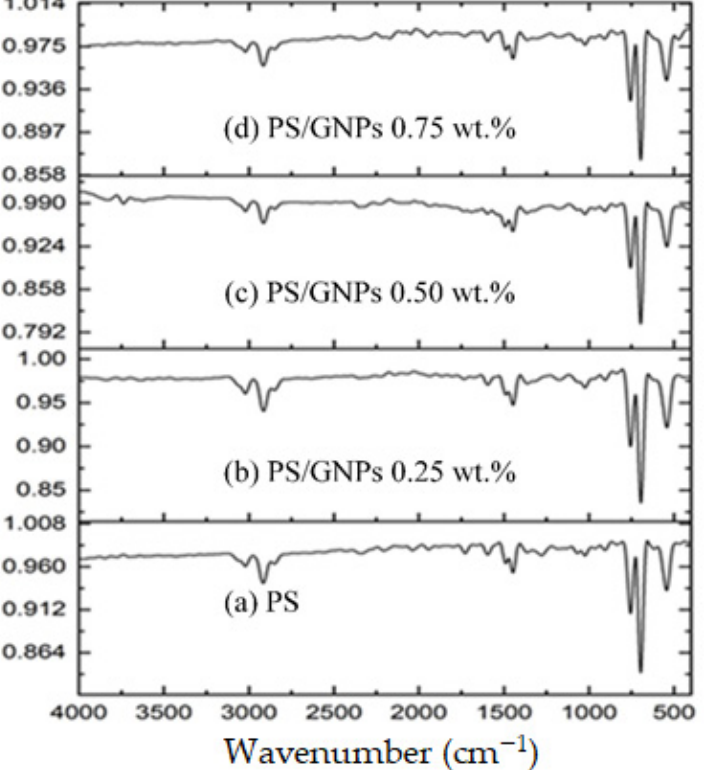
Figure 5. FTIR for: ( a ) Blank PS membrane ( b ) Composite PS/GNPs membrane with 0.25 wt.% ( c ) Composite PS/GNPs membrane with 0.5 wt.% ( d ) Composite PS/GNPs membrane with 0.75 wt.%.